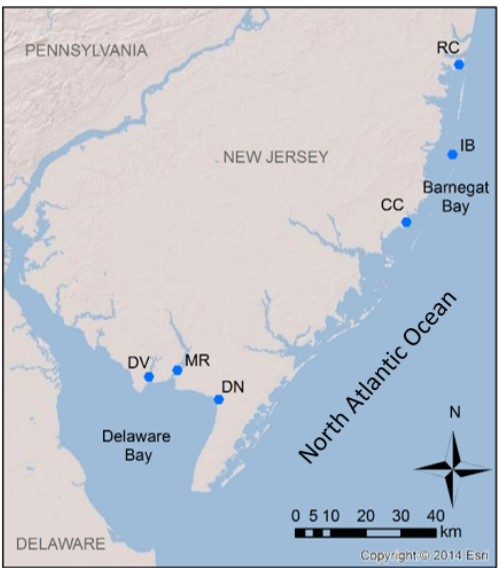
Figure 1. Study locations in Barnegat Bay and Delaware Bay along the mid-Atlantic coast,